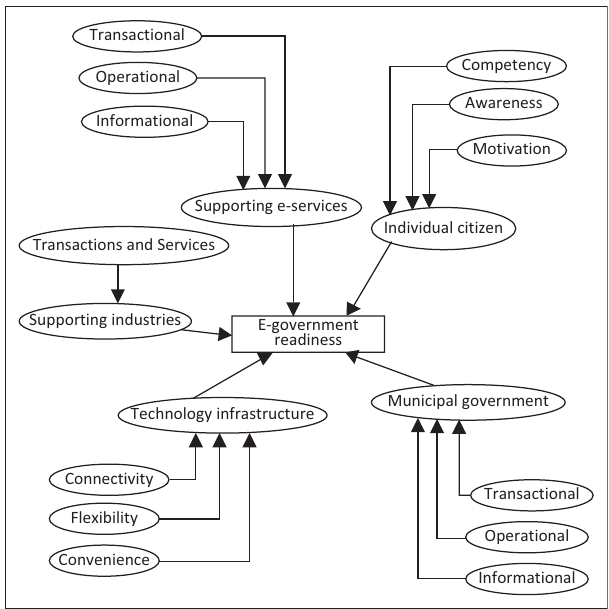
FIGURE 1: Municipal e-government readiness